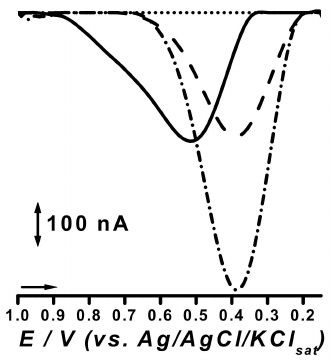
Figure 3. Differential pulse (DP) voltammograms obtained for 133 μM catechol solution at carbon paste electrode (CPE) ( ), PdO@CPE ( ▬▬ ), and TiO 2 @CPE ( • ) sensors and for blank at TiO 2 @CPE sensor (• • •), all in 0.1 M phosphate buffer solution (PBS), pH 7.0.